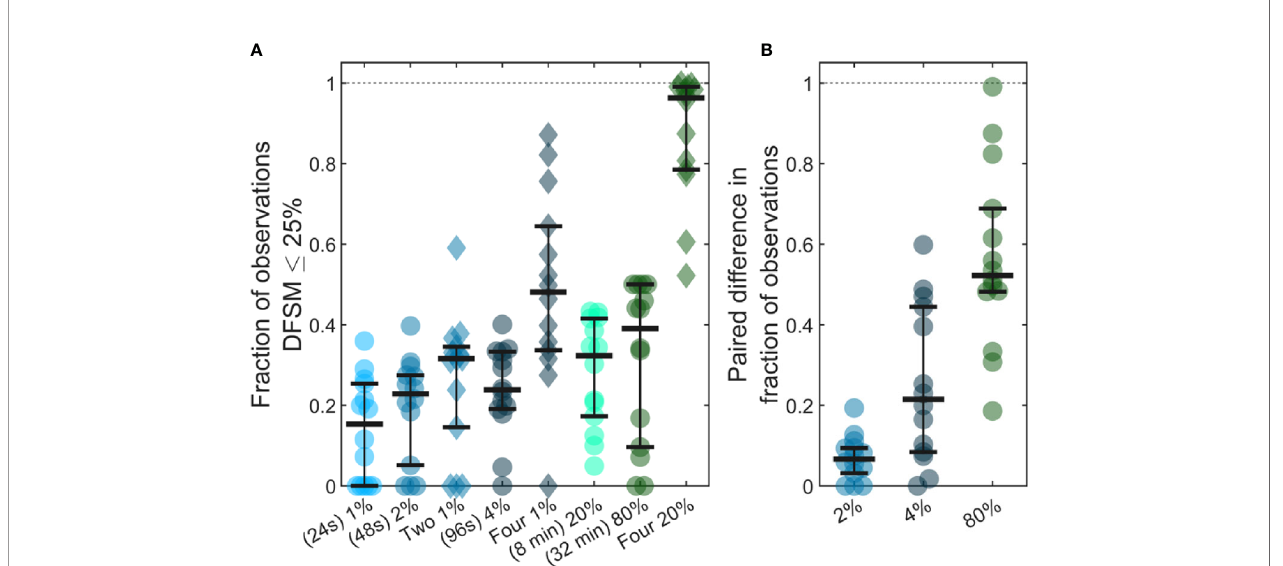
FIGURE 7 | Use of larger blood samples and averaging multiple blood samples yields improved enumeration of CTCs. (A) Fraction of samples of different sizes where the DFSM was less than or equal to 25% for 1%, 2%, two 1%, 4%, four 1%, 20%, 80%, and four 20% PBV samples. (B) Paired difference in the fraction of samples were the DFSM <= 25% between the averaged samples (two 1%, four 1%, and four 20% PBV) and a single continuous sample of equivalent size (2%, 4%, and 80%